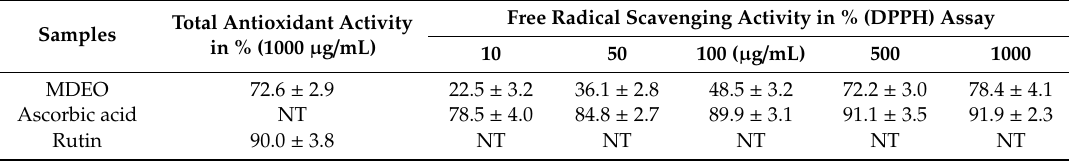
Table 4. Antioxidant activity and free radical scavenging activity of MDEO.